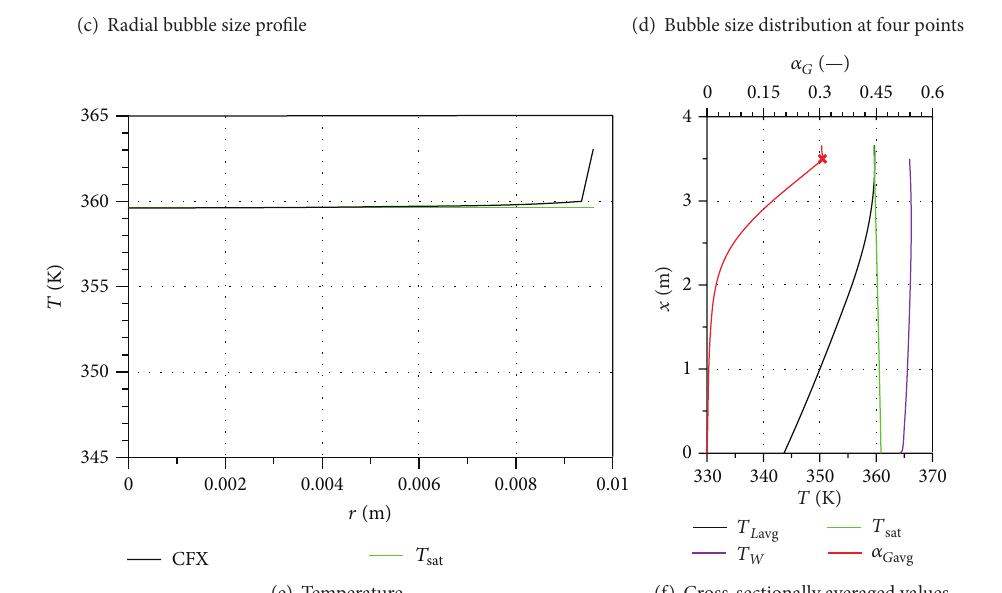
(f) Cross-sectionally averaged values